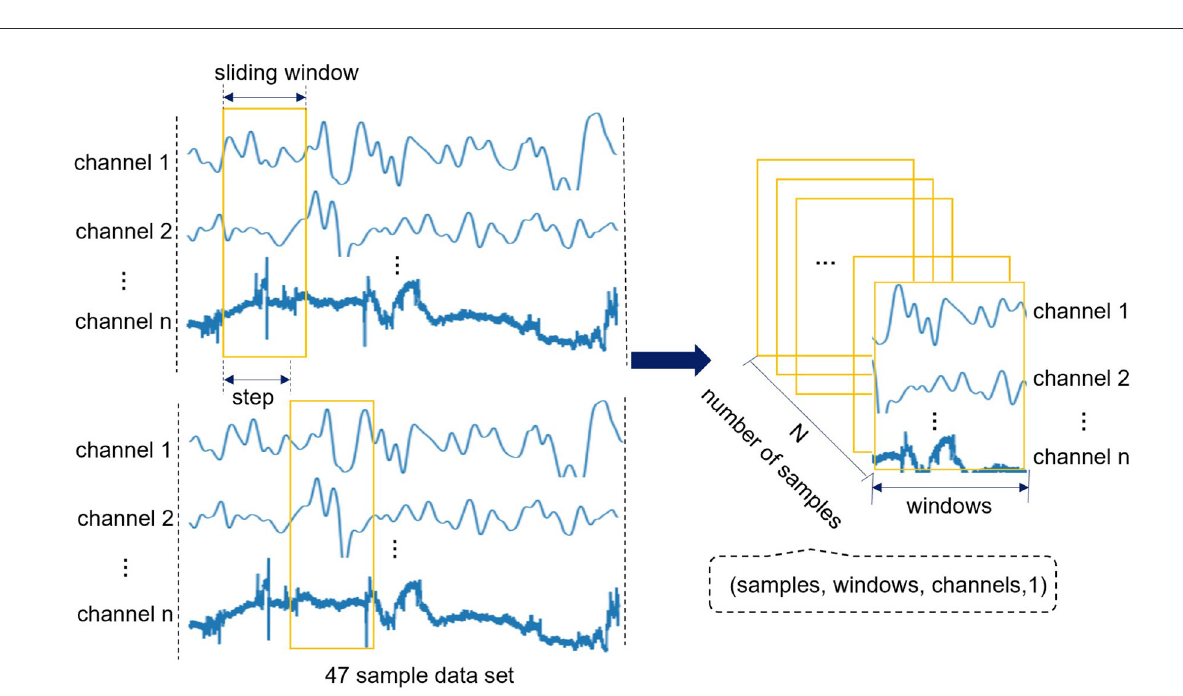
functions or similarity measures (Geng et al., 2019). Therefore, the pre-defined graph cannot contain all the spatial information of nodes, and is not directly related to the classification